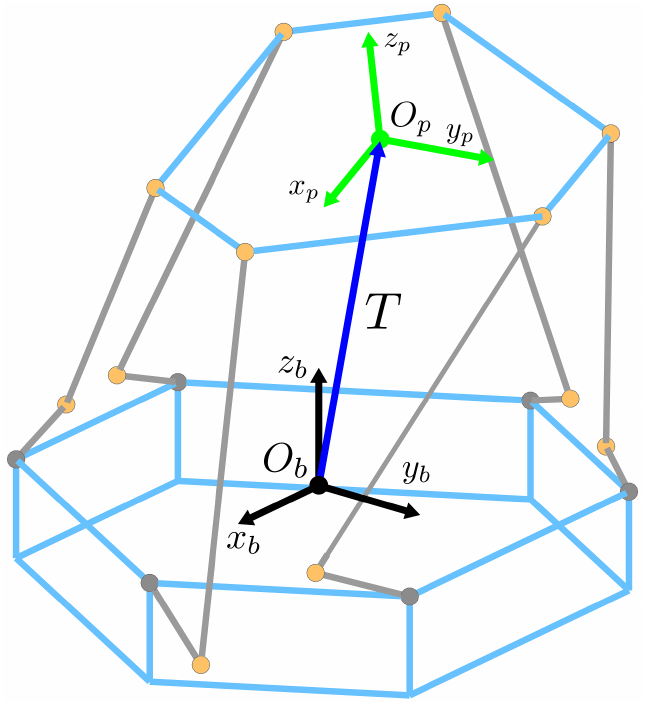
Figure 3. Global and platform’s reference